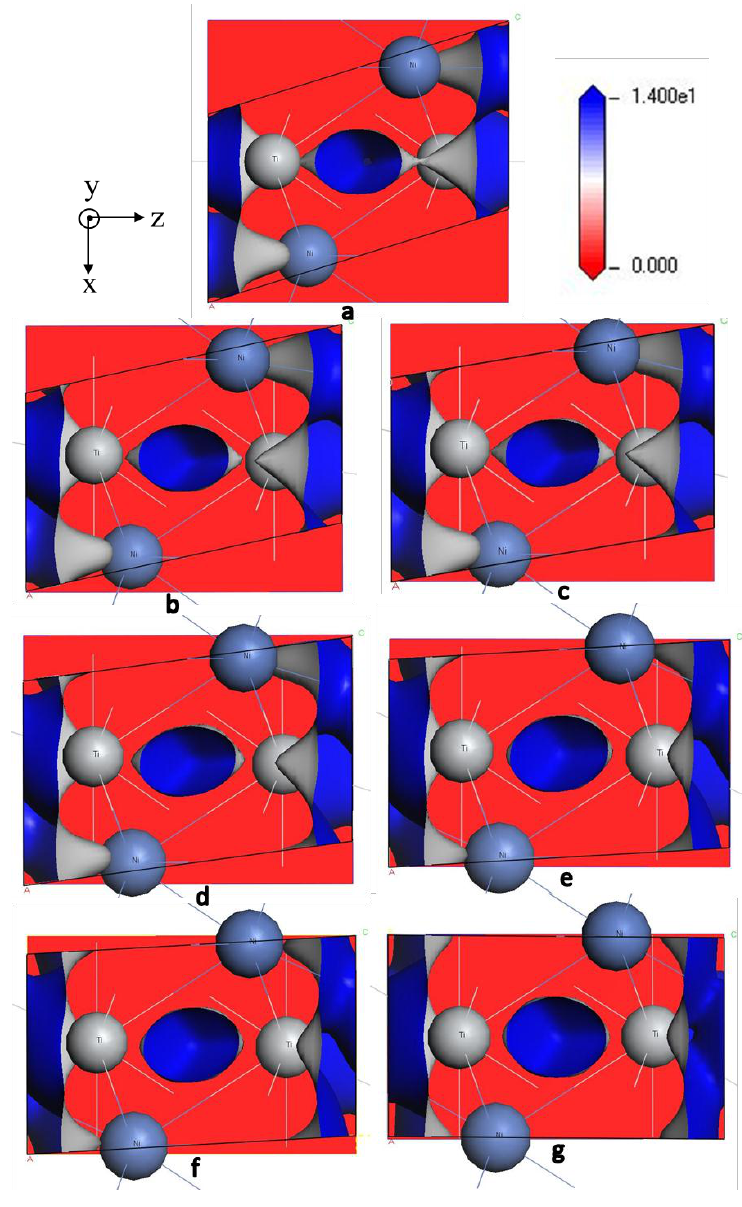
Figure 7. 2D total electron density projection plots in the XZ plane with color legend indicating magnitude of charge distribution for ( a ) binary Ti 50 Ni 50 ; ( b ) Ti 50 Ni 45 Cu 5